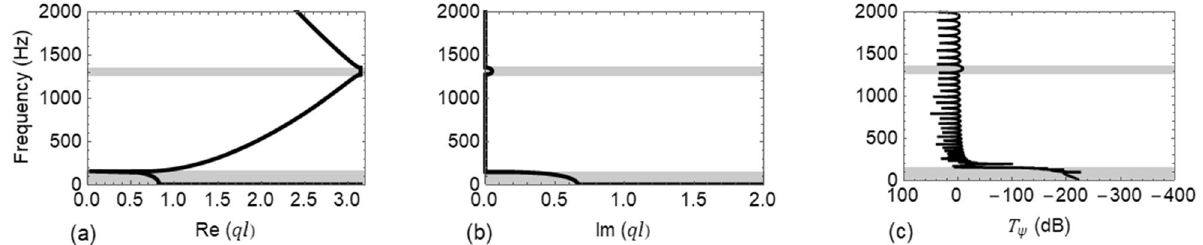
Figure 6. Dispersion curves and transmittance T ψ ( dB ) of Wave #B: ( a ) real part of the dispersion relation, Re ( ql ) ; ( b ) imaginary part of the dispersion relation, Im ( ql ) ; and ( c ) T ψ ( dB ) .